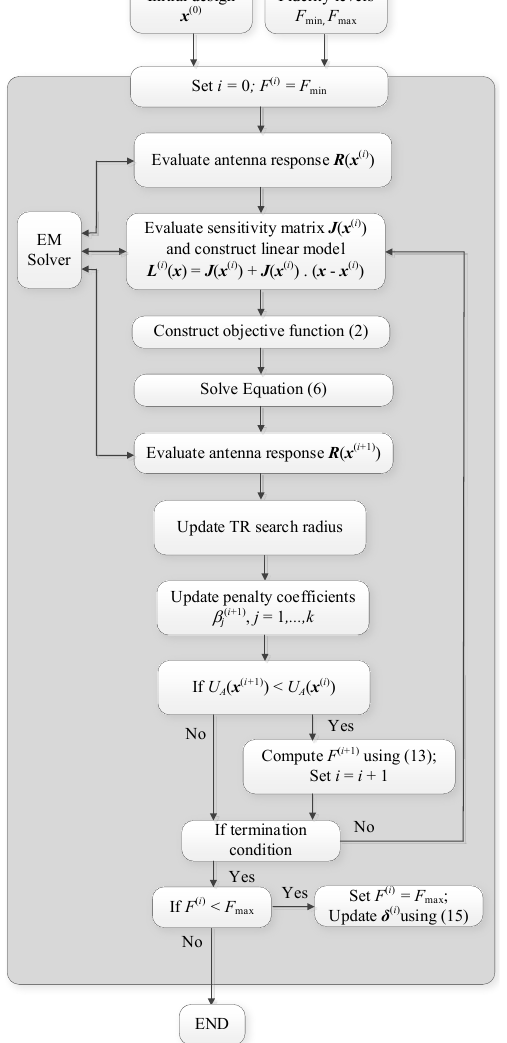
Figure 5. Operational flow of the proposed miniaturization procedure incorporating constraint– convergence-based model-fidelity adjustment scheme.